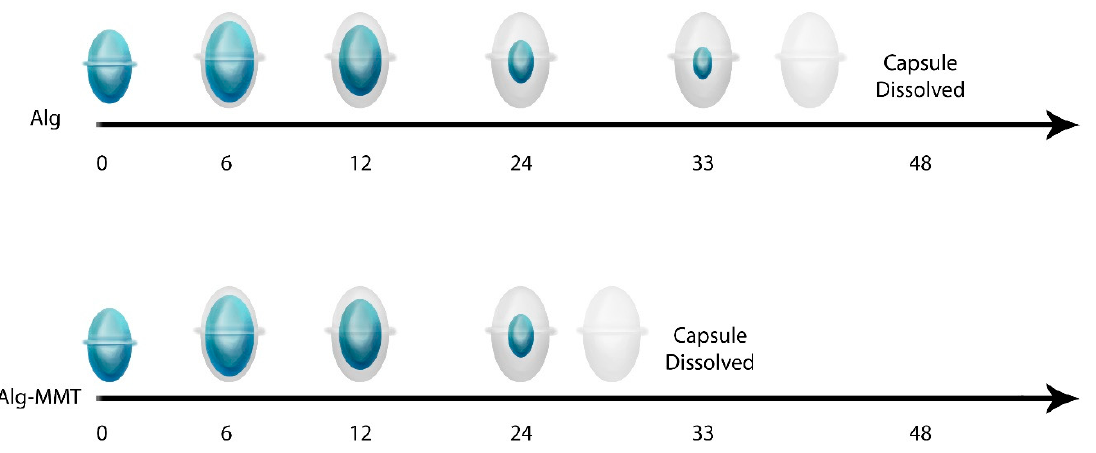
Figure 11. Based on the real-time imaging (Figure 7), capsule disintegration pattern at specific time-points.